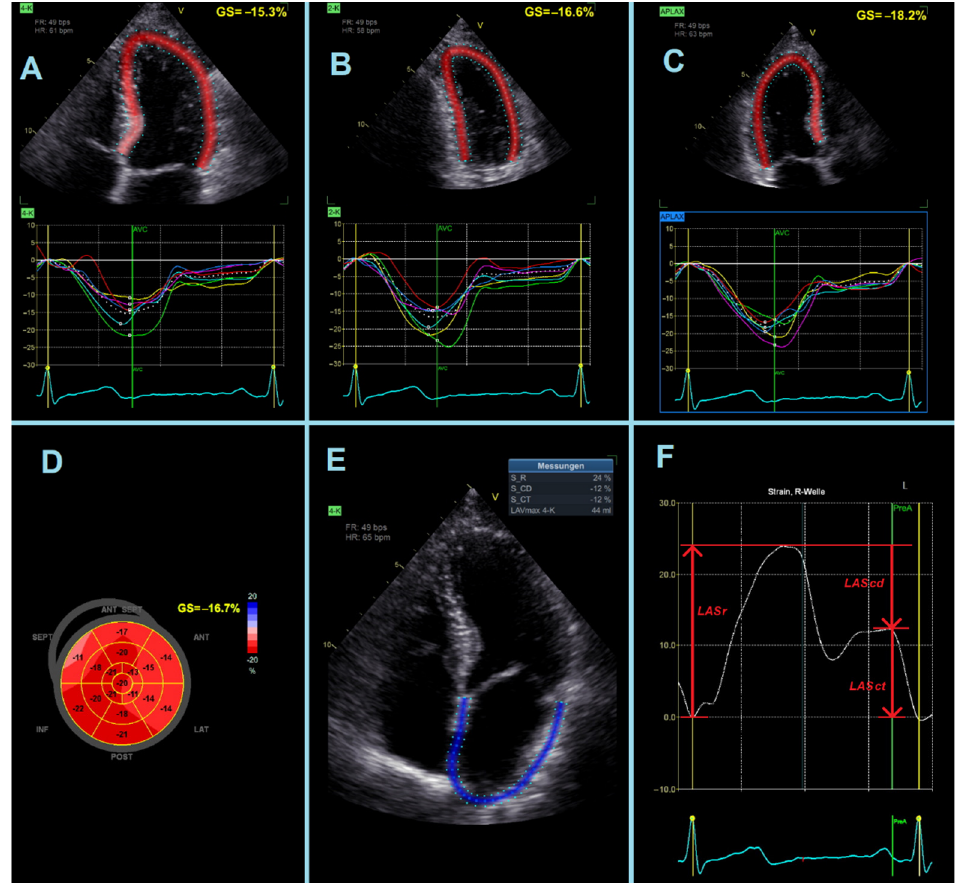
Figure 2. Speckle tracking echocardiography with left ventricular global longitudinal strain (LV- GLS) assessment ( A ) apical 4-chamber view; ( B ) apical 2-chamber view; ( C ) apical 3-chamber view; ( D ) Bull’s-eye plot), and left atrial strain assessment (LAS) in apical 4-chamber view ( E,F ).